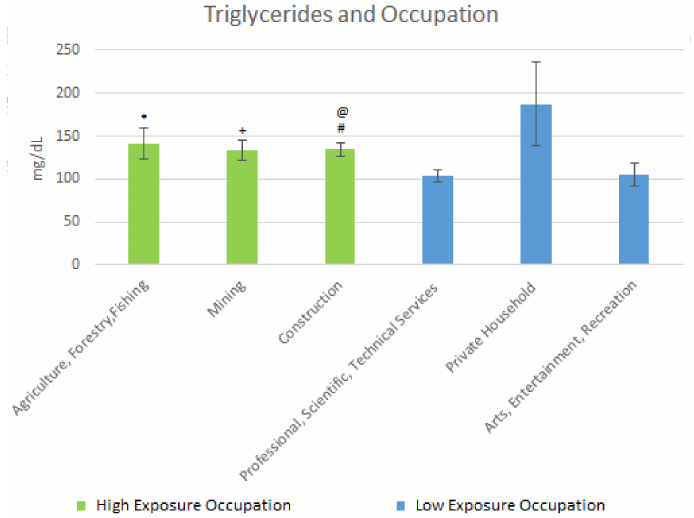
Figure 5. Occupation and Triglycerides Levels. * Moderately significant difference between Agriculture, Forestry, Fishing and Professional, Scientific, Technical Services; + Significant difference between Mining and Professional Scientific, Technical Services; # Significant difference between construction and Professional Scientific, Technical Services; @ Moderately significant difference between Construction and Arts, Entertainment,